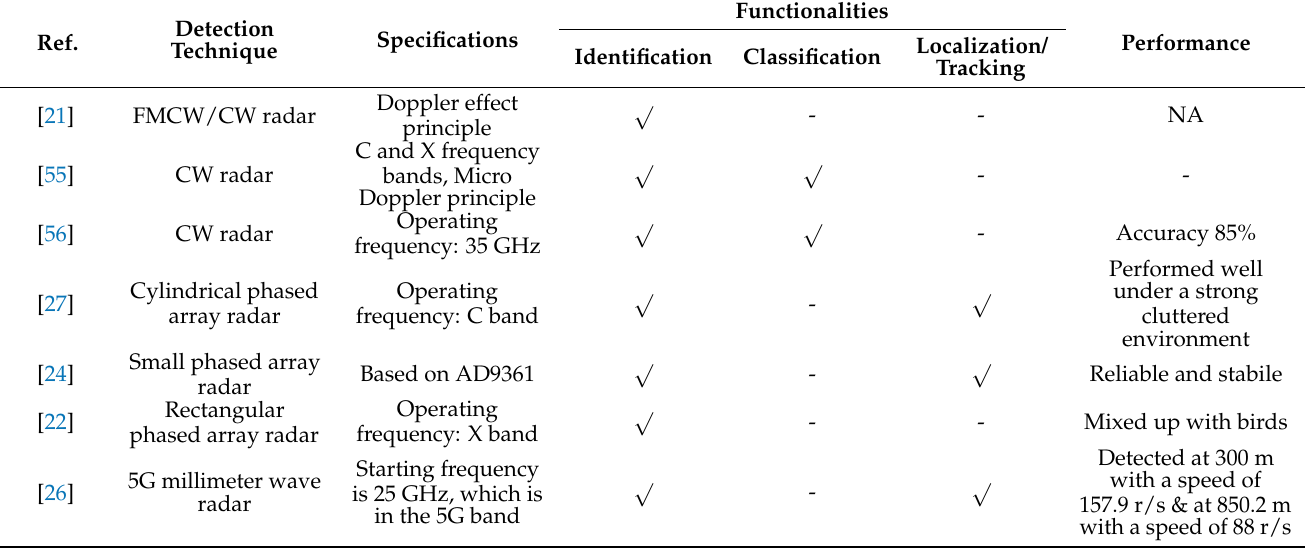
Table 3. Summary of reviewed radar-based techniques for UAV